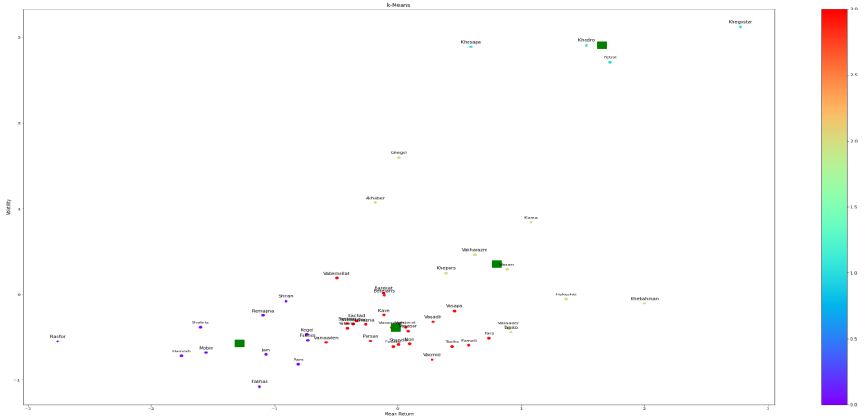
Figure 4. K-Means